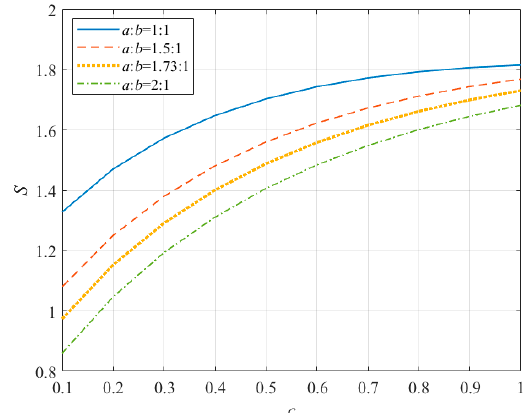
Figure 4. The shape entropies of non-convex shapes are shown in Figure 3, provided that b = 1, a = 1, √ 1.5, 3, 2, and c ∈ [0.1,